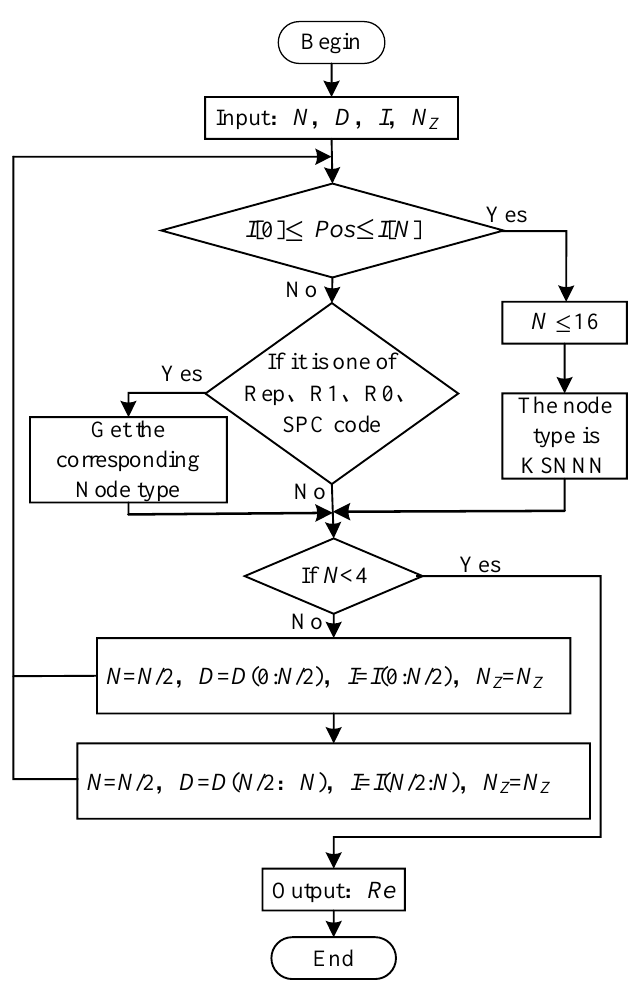
Figure 11. KSNNN identification flowchart.